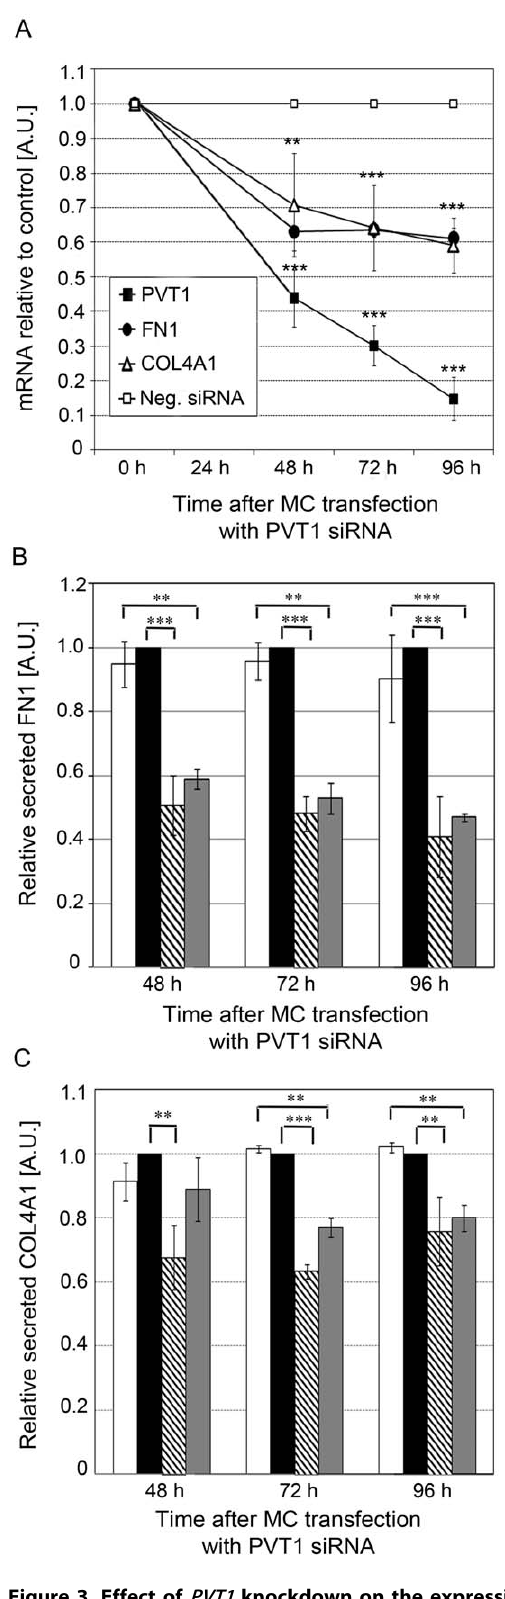
Figure 3. Effect of PVT1 knockdown on the expression of FN1 and COL4A1 . ( A ) PVT1 , FN1 and COL4A1 mRNA levels following transfection of MC with PVT1 siRNA. Data were obtained by qPCR analysis and presented as mRNA fold-increase compared with Neg siRNA. Non-transfected (NT) MC were used as a second